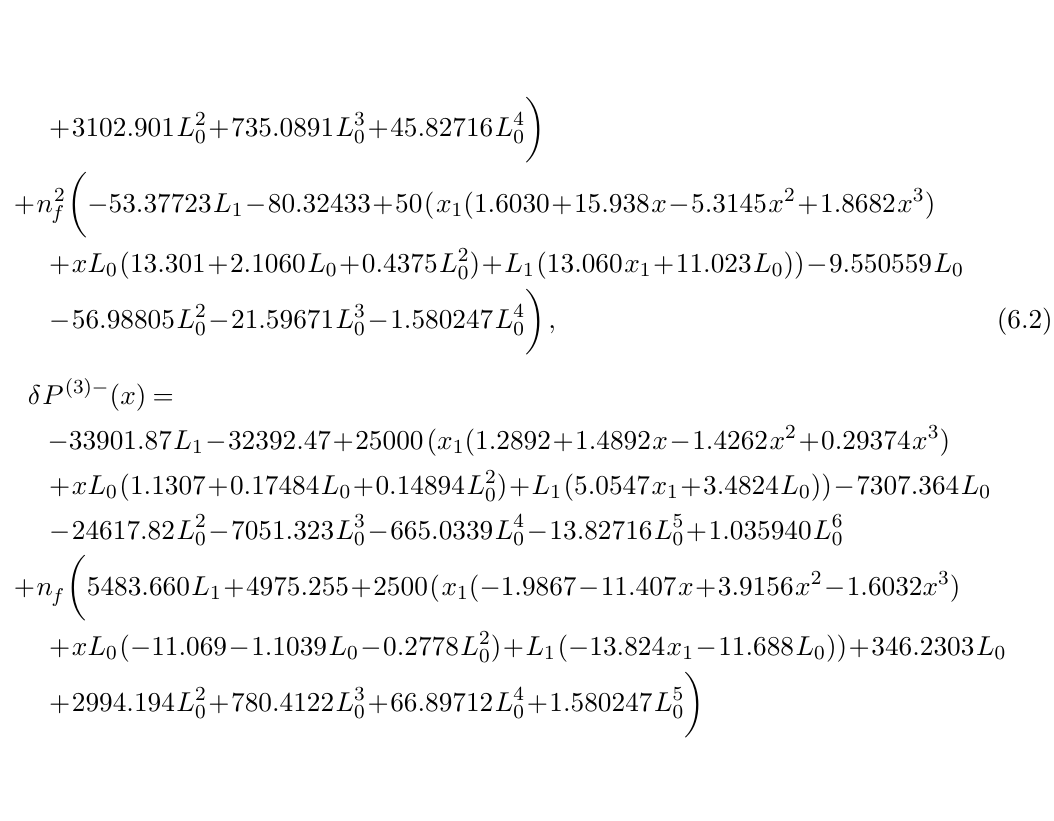
in eq. (5.10). Right panel: the relative N 2 LO ns for the characteristic non-singlet ns